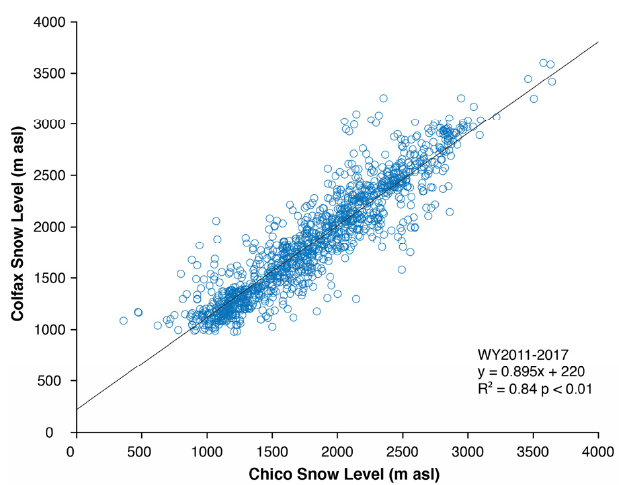
Figure 3. Scatterplot of hourly Chico versus Colfax observed winter snow levels between WY2011 and 2017. Outlier points exceeding 1000 m difference between stations were removed for a total of n = 1195 observations.